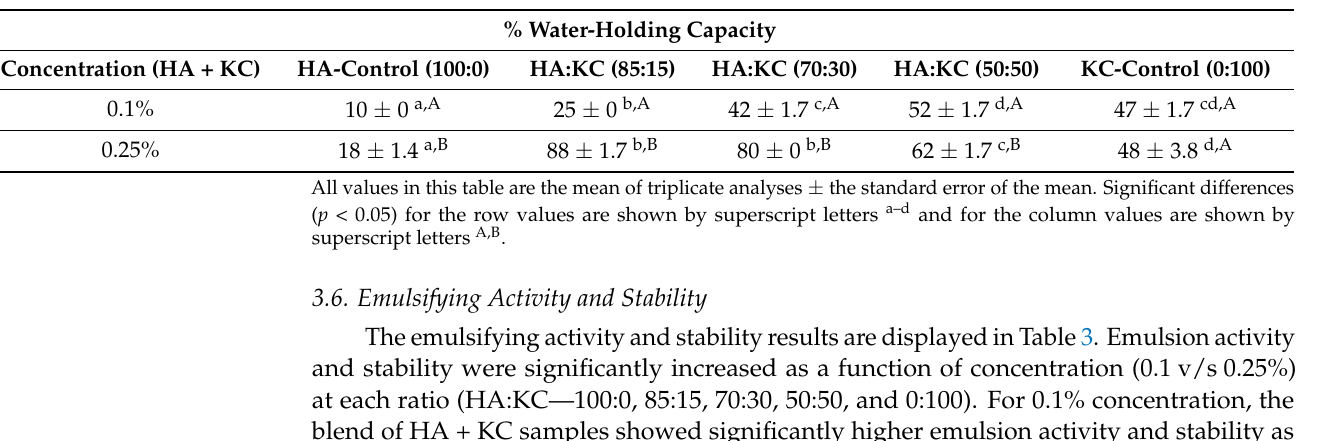
Table 2. Water-holding capacity of skim milk samples treated with different concentrations and ratios of HA + KC